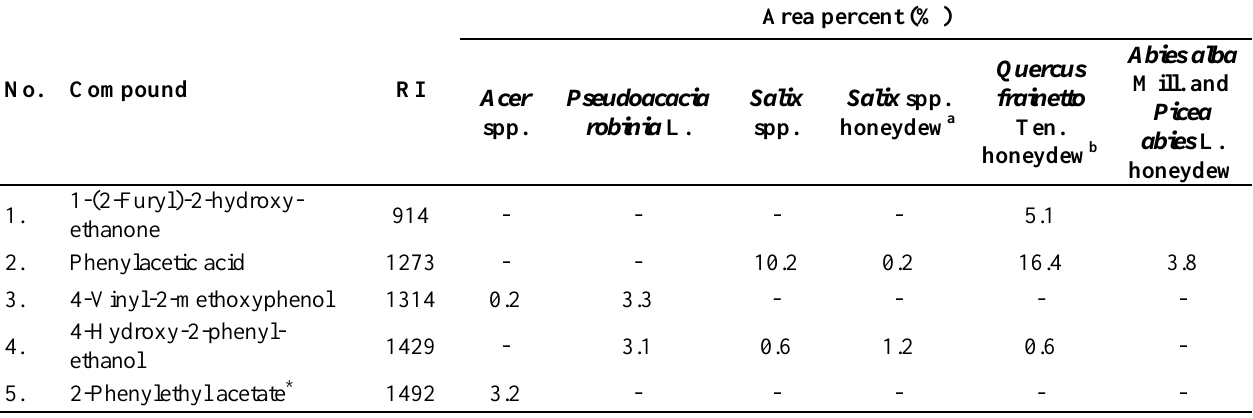
Table 2. Comparison of major volatile constituents of Acer spp. honey sample and other representative Croatian tree honey samples obtained by USE with the solvent pentane- diethyl ether (1:2 v/v) followed by GC and GC/MS